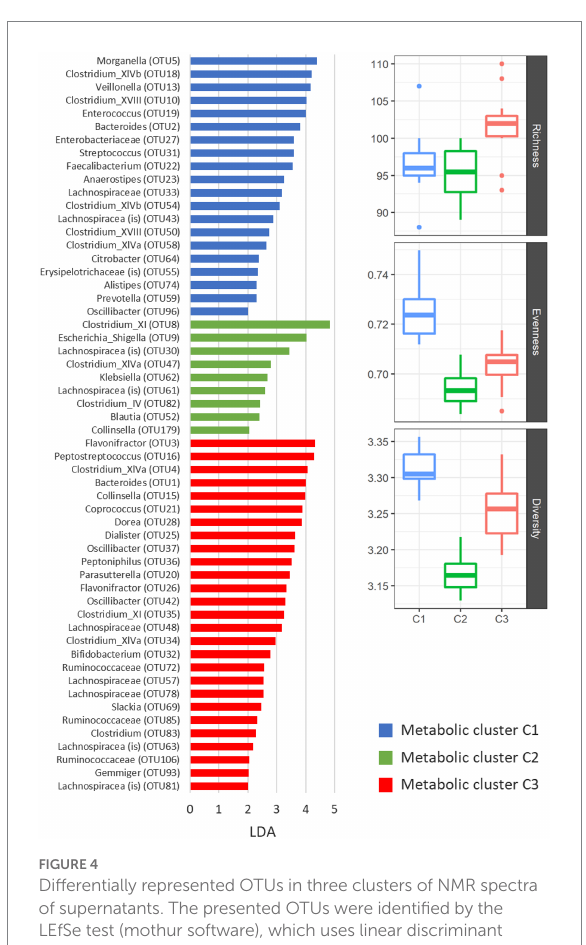
FIGURE 4 Differentially represented OTUs in three clusters of NMR spectra of supernatants. The presented OTUs were identified by the LEfSe test (mothur software), which uses linear discriminant analysis (LDA) to find OTUs, which significantly differ in abundance between all groups of samples. Alpha indexes are presented with boxplots for each metabolic cluster separately. We used number of unique OTUs for richness estimation, Shannon eveness for eveness estimation and Shannon for community